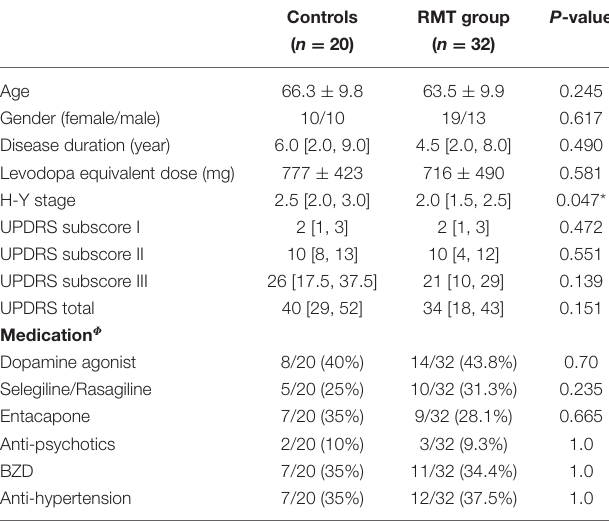
TABLE 1 | Comparison of demographic and laboratory data between groups of disease control subjects and patients with